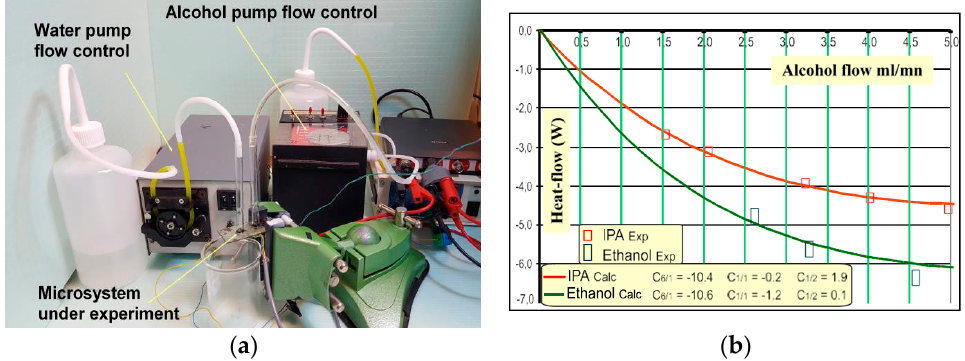
Figure 4. ( a ) Global view of the characterization system (G = 1000). ( b ) Compared values regarding measurements Φ mes = V out /G. ζ and theoretical expected values calculated from Equation